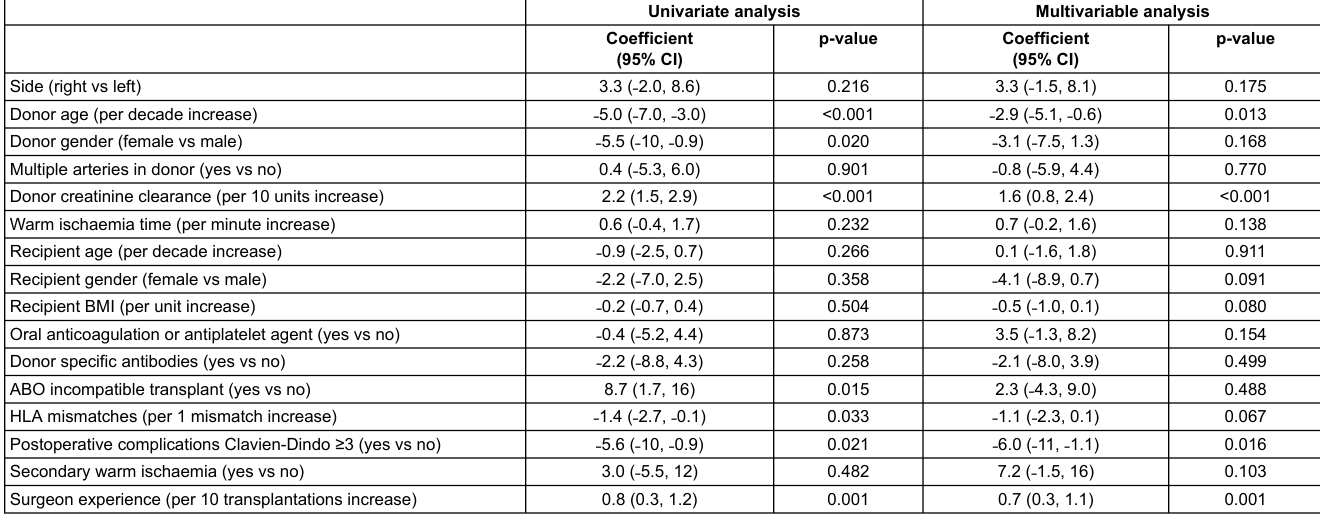
Table 4: Linear regression model for recipient creatinine clearance one year after transplant (n = 2 46) *